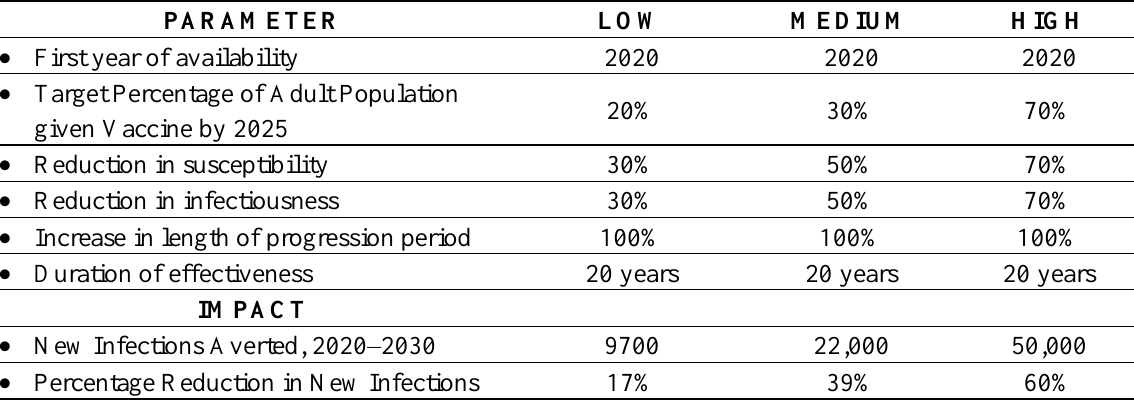
Table 2. HIV vaccine scenarios and associated impact in Sichuan